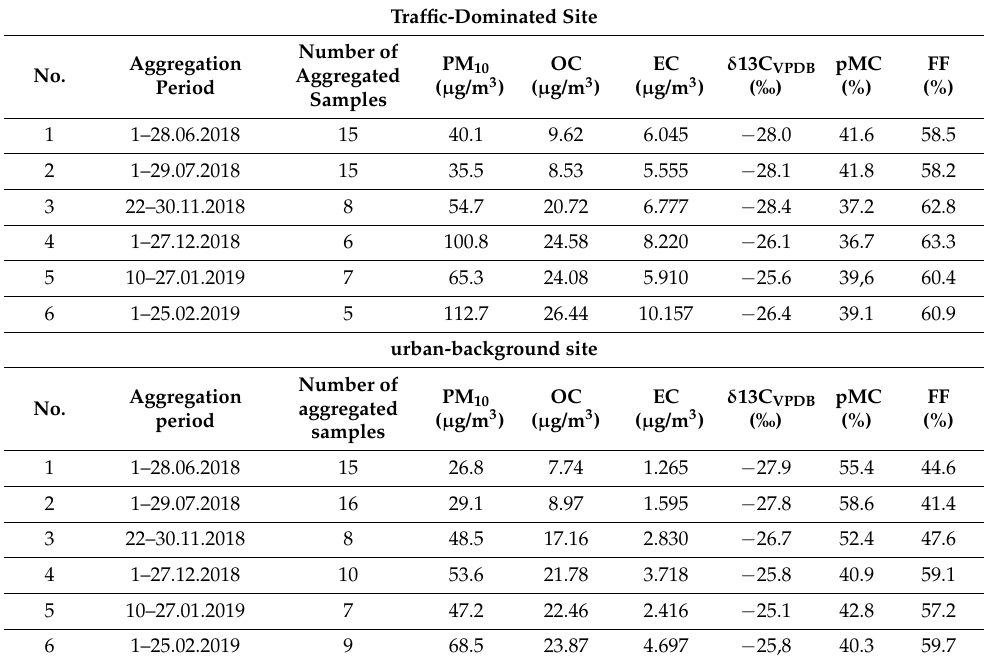
Table 1. The characteristics of monthly aggregated PM 10 samples (traffic-dominated site and urban- background